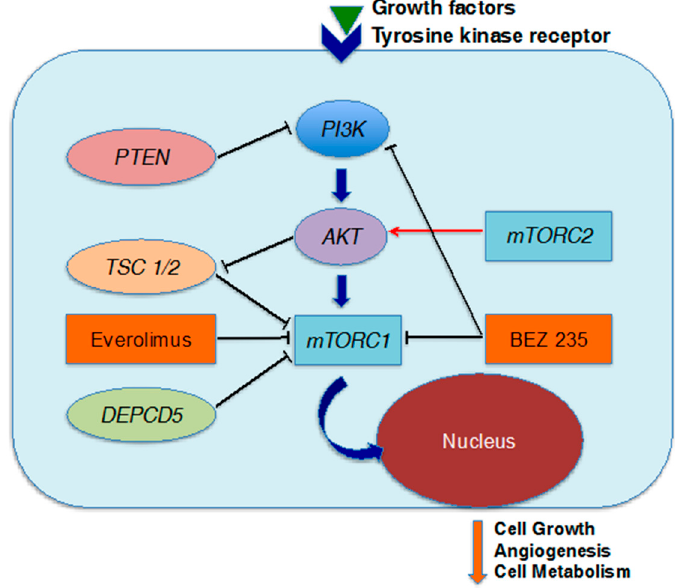
Figure 3. The mTOR signaling pathway as a target of molecular therapies. At the onset of pNENs, the upregulation of mTOR complex 1 (mTORC1) leads to cell growth, angiogenesis and cell metabolism. Everolimus suppresses mTORC1, and BEZ235 concurrently suppresses PI3K and mTORC1. Red arrows represent activation and black bars inhibition in each cascade.